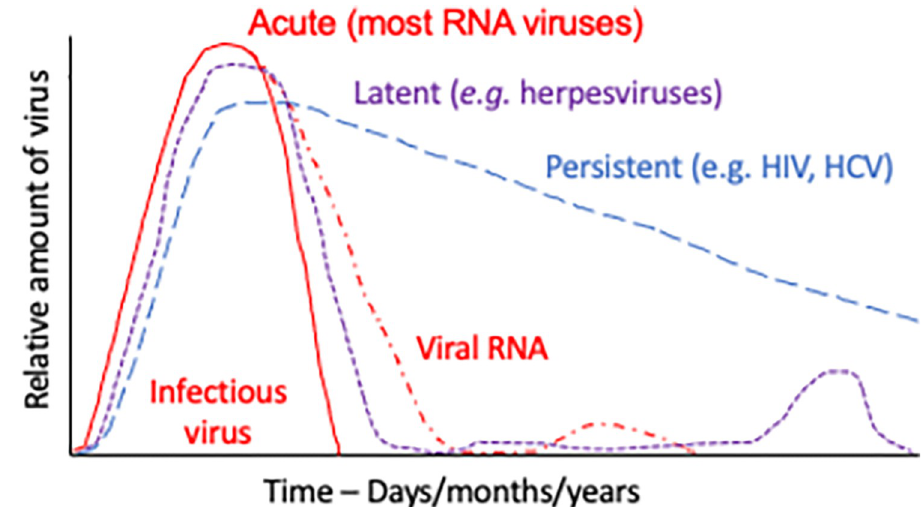
Fig 1. Patterns of virus production over time that maintain human viruses within the population. Representative patterns are shown for RNA viruses often associated with persistent RNA that can cause late complications and occasionally reactivate (red), viruses that establish latency and reactivate (such as herpesviruses) (purple), and viruses not cleared by the immune response that continue to produce infectious virus (such as HIV and HCV) (blue). H AU : AbbreviationlistshavebeencompiledforthoseusedthroughoutFigs 1 (cid:0) 3 : Pleaseverifythatallentriesarecorrect : CV, hepatitis C virus; HIV, human immunodeficiency